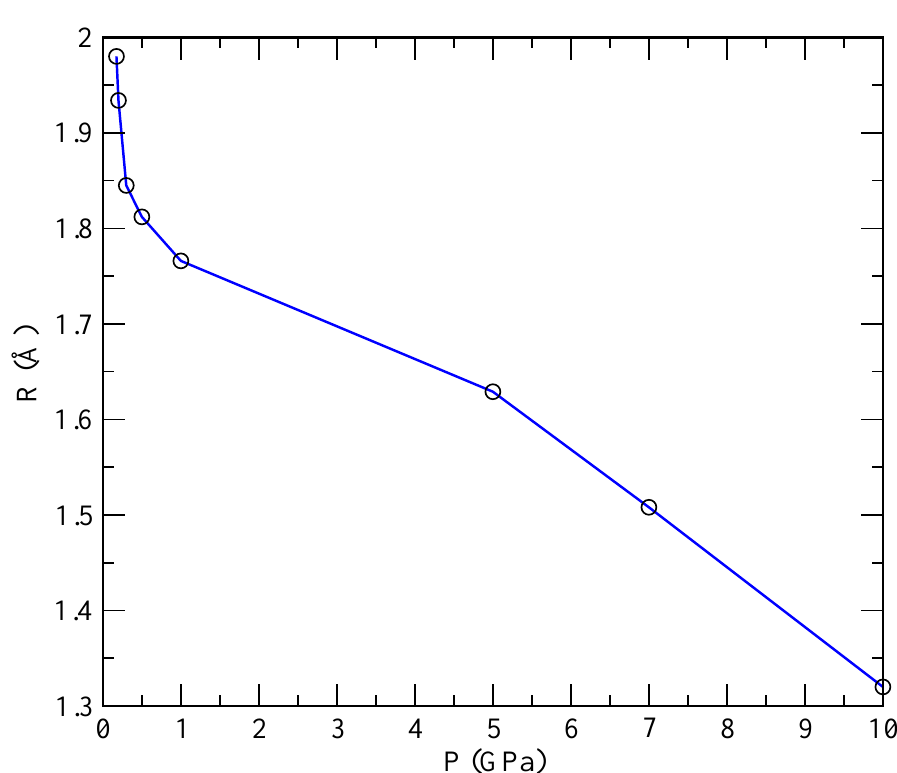
Figure 9. Radii of helium droplets for the pressure range 0.175–10